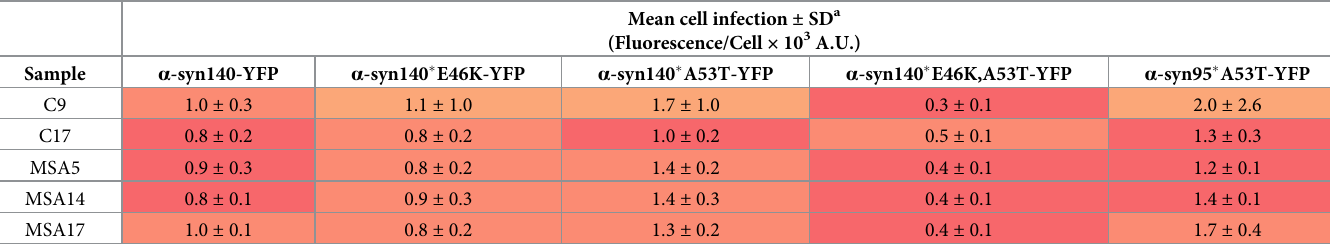
Table 1. Infectivity of TgM47 +/- passaged MSA prions in cultured cells.